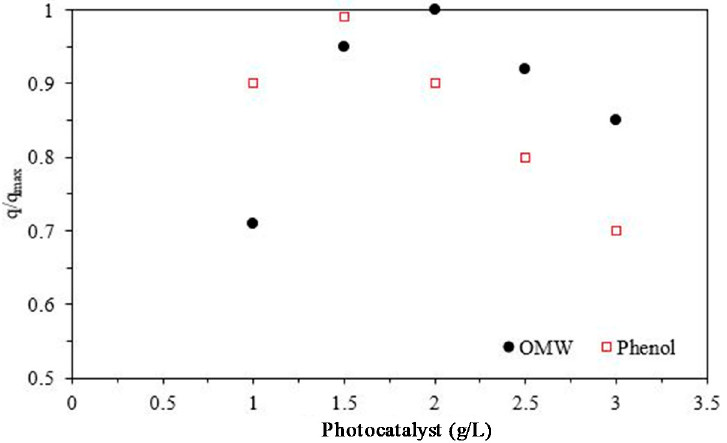
Figure 4. COD and phenols sorption removal obtained at a different photocatalyst concentration (T = 25 °C, initial OMW COD = 9.4 g L − 1 , synthetic solution initial concentration = 25 mg L − 1 , the contact time in dark = 30 min, q = mg of COD or phenols sorbed/g of photocatalyst and q max is the maximum value of q, impeller rotational velocity = 200 rpm).